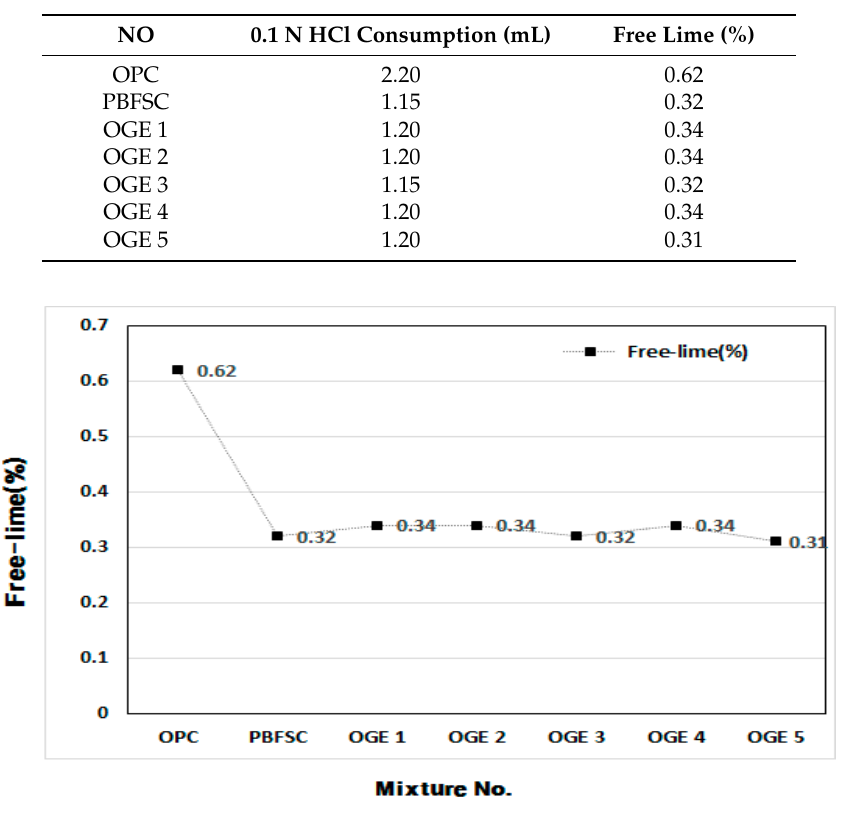
Figure 14. Measured value of free-lime in OGE at different ESA burning temperatures.